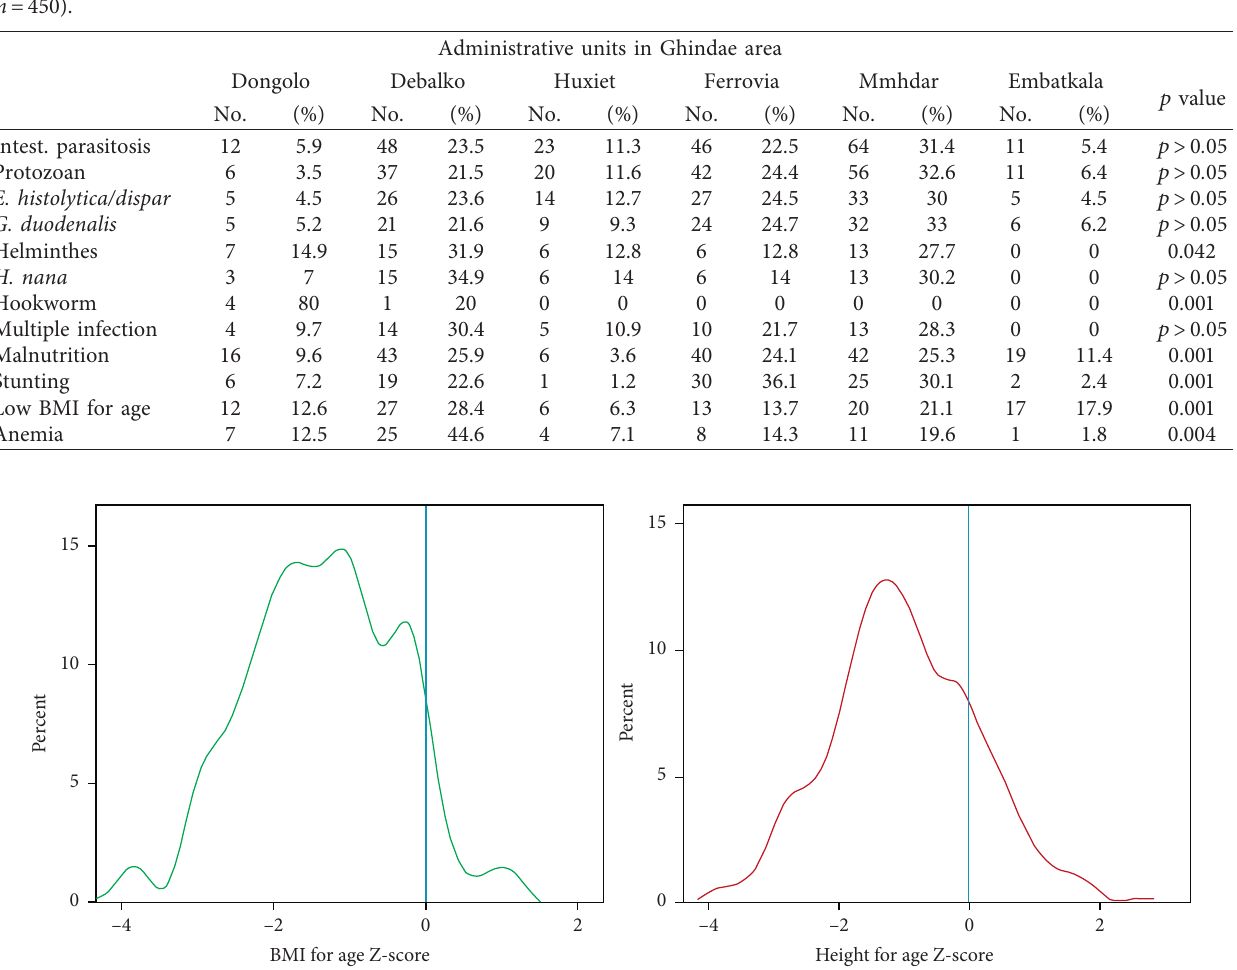
Figure 2: Kernel density plots of BMI for age and height for age Z-scores for all students in Ghindae area, Eritrea,